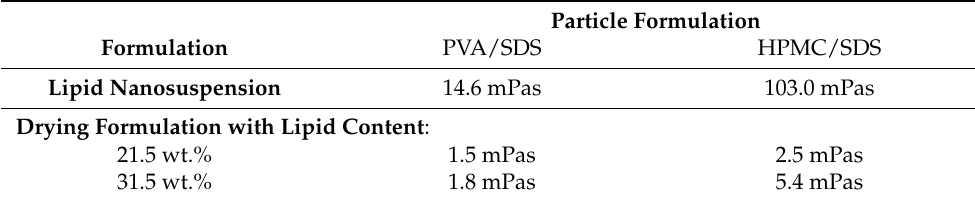
Table 1. Viscosity of lipid nanosuspensions after high-pressure homogenization and of the formula- tions prepared directly before spray drying, containing the suspension and the matrix former solution, for the two particle stabilization systems (during high-pressure homogenization): PVA/SDS and HPMC/SDS.